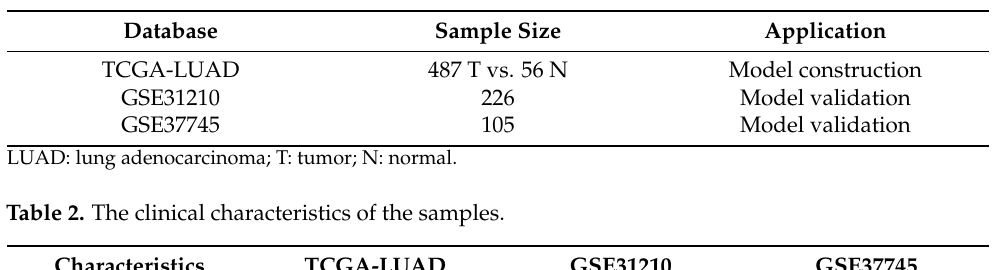
Table 1. Sample information.